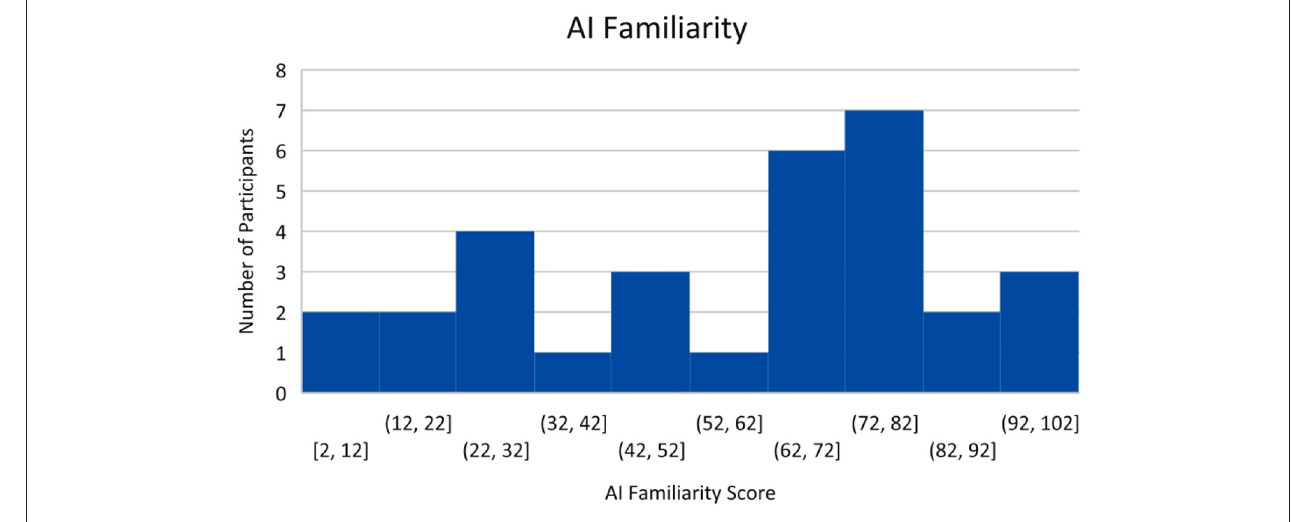
FIGURE 8 | AI familiarity.